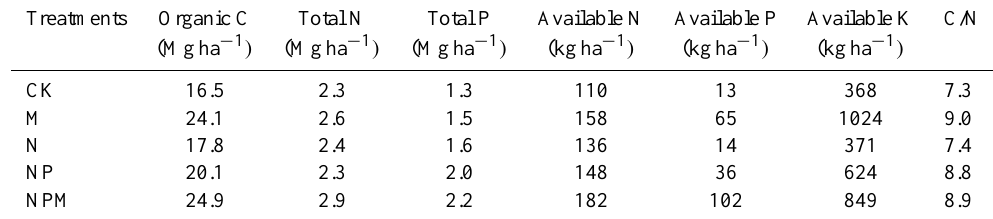
Table 1. Soil fertility after 22 years of fertilization management (0–20cm). Treatments Organic C Total N Total P Available N Available P Available K C/N CK